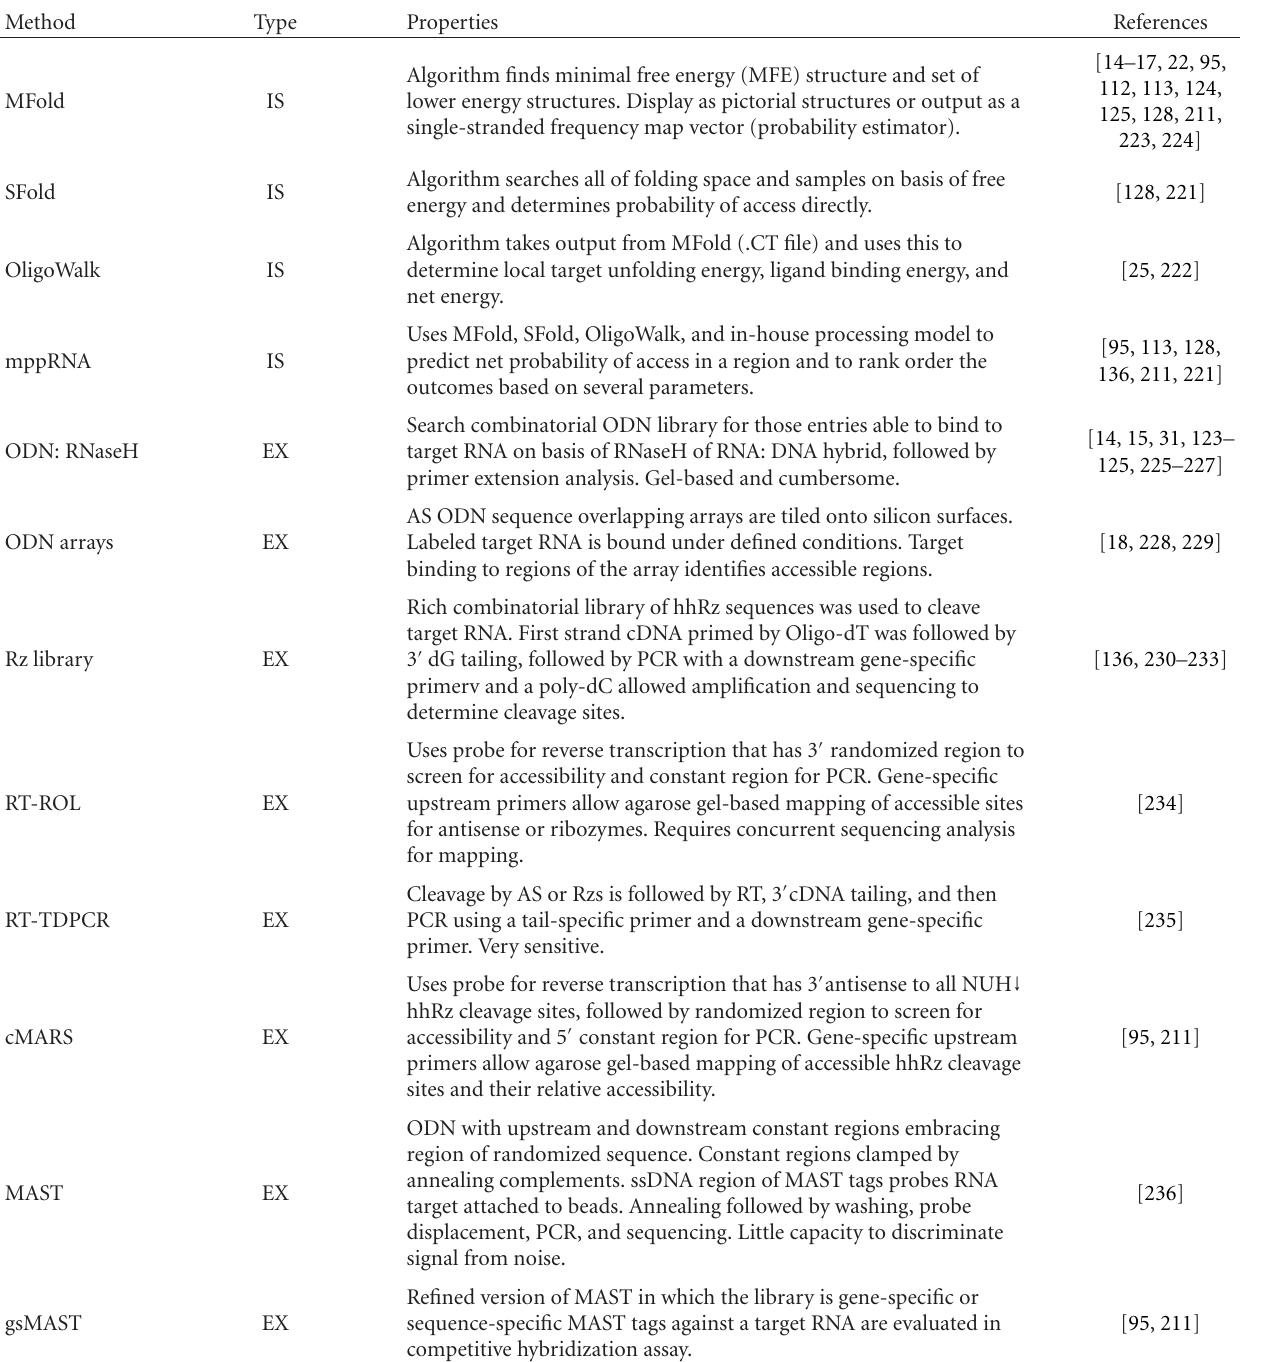
Table 2: Methods to identify accessible sites in target